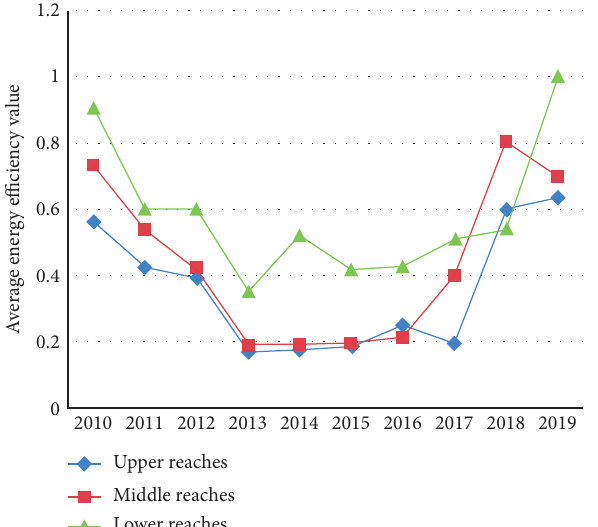
Figure 3: Average energy efficiency values of the logistics industry in the upper, middle, and lower reaches of the Yangtze River Economic Belt from 2020 to 2019.